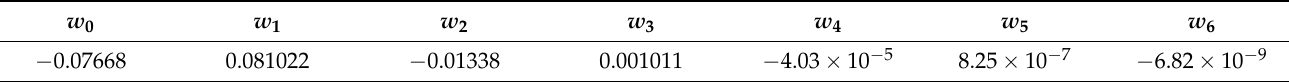
Figure 2. Wave steepness, s obtained through linear interpolation in Table 1. Table 2. Values of the coefficients in Equation (3), w